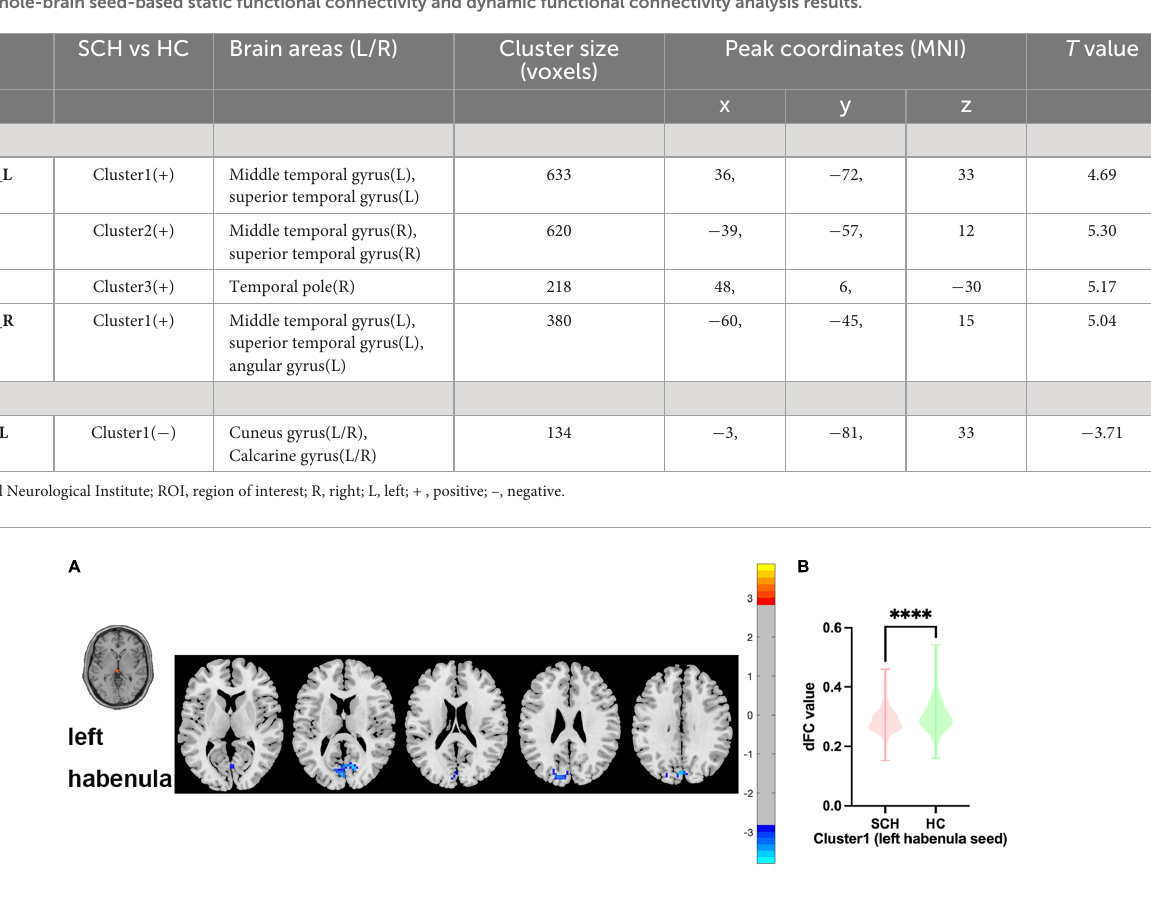
with the sFC of cluster 3 using the left habenula seed in SCH group ( r = –0.226, p = 0.019). The scores of G3 (anxiety) were positively correlated with the dFC of cluster 1 using the left habenula seed in SCH group ( r = 0.212, p =